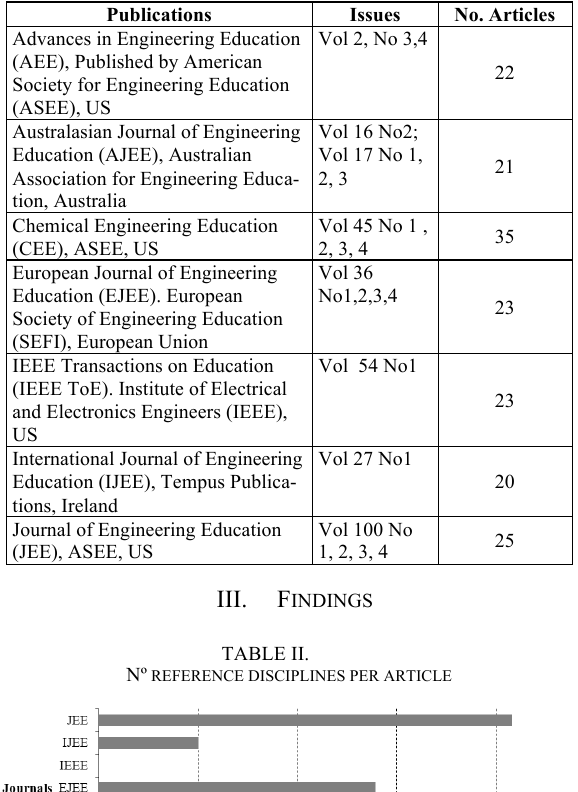
TABLE I. P UBLICATIONS AND N UMBER OF ARTICLES ANALYZED FOR 2011.